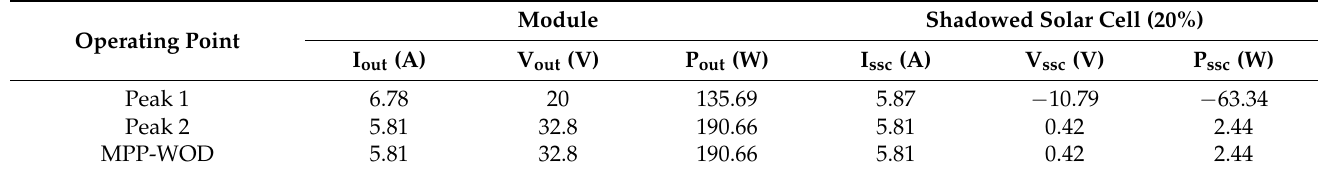
Table 3. Parameters of the shadowed solar cell and the simulated PV module with a solar cell that has a shadow ratio of 20%. Operating Point